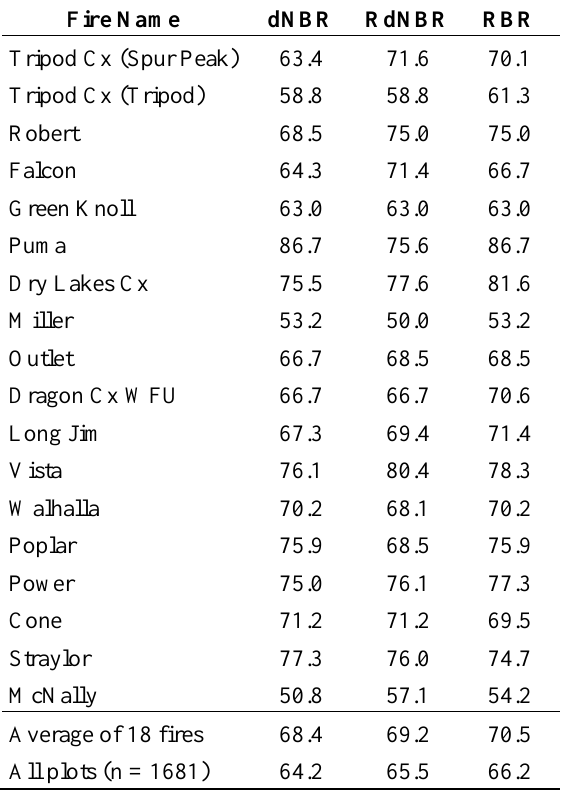
Table 2. Overall classification accuracy when classifying plots into discrete severity classes of unchanged, low, moderate, and high. The last two rows depict the average classification accuracy among the 18 fires and of all plots analyzed simultaneously,